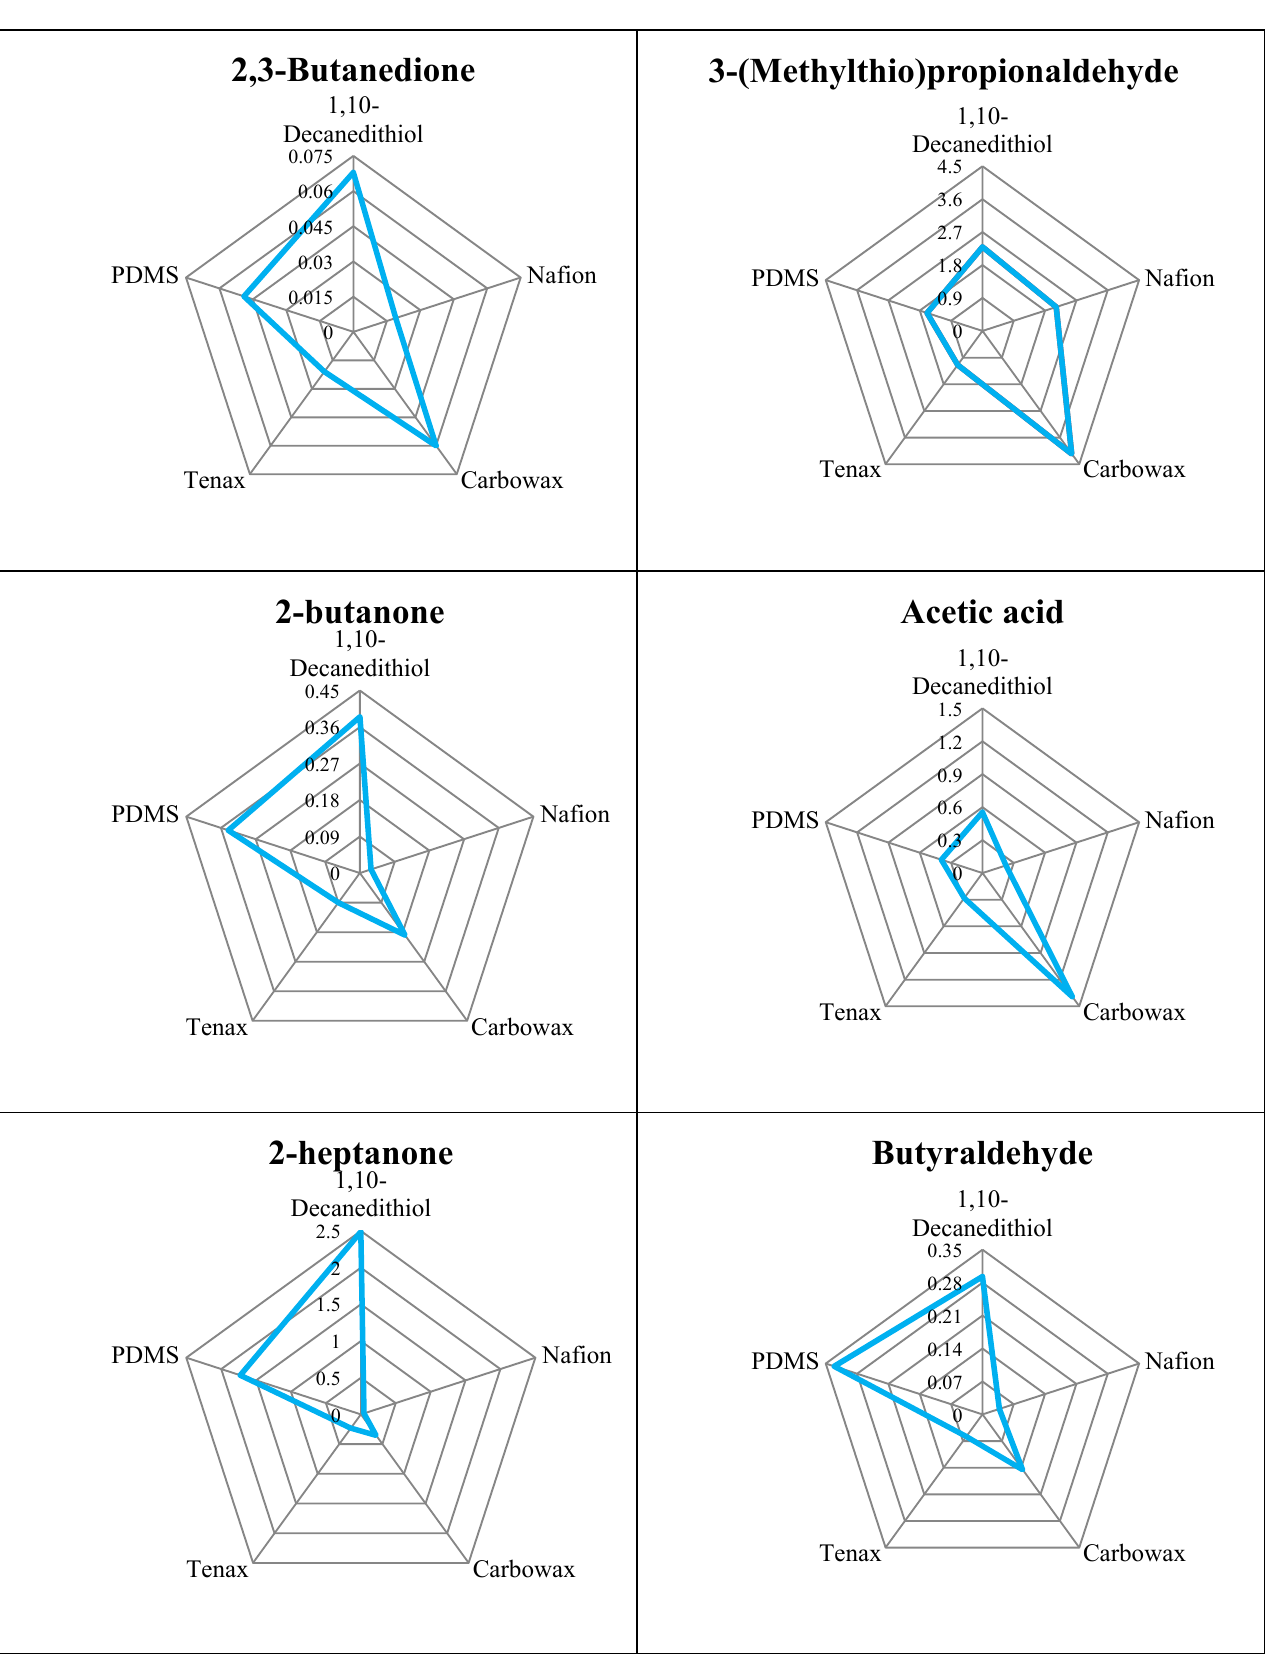
Figure 3. Sensitivities (Hz/ μ g) of the five sensors to a few volatiles ordinarily present in cheese